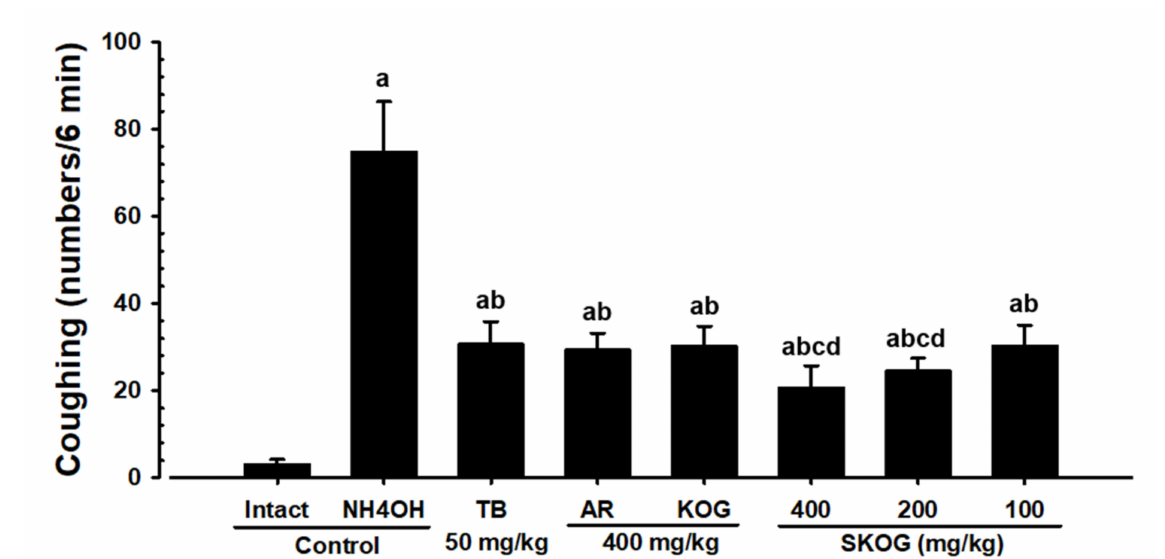
Figure 1. Effects of adenophorae radix powder (AR), kyeongok-go (KOG), and shashamkyeongok-go (SKOG) on the changes of coughing frequencies in NH 4 OH-induced coughing mice. Values are expressed as the mean ± SD of 10 mice. Different letters indicate statistical significance. Treatment groups expressed as a p < 0.01, b p < 0.01, c p < 0.01, and d p < 0.01 compared with the intact vehicle control, NH 4 OH control, AR 400 mg/kg, and KOG 400 mg/kg by the Mann-Whitney U (MW) test,